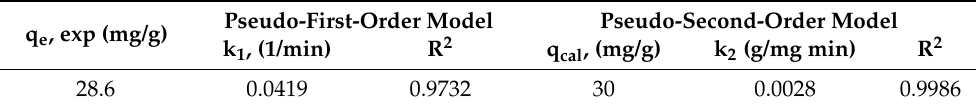
Table 5. Comparison of the kinetic models for the adsorption of Cu 2+ .